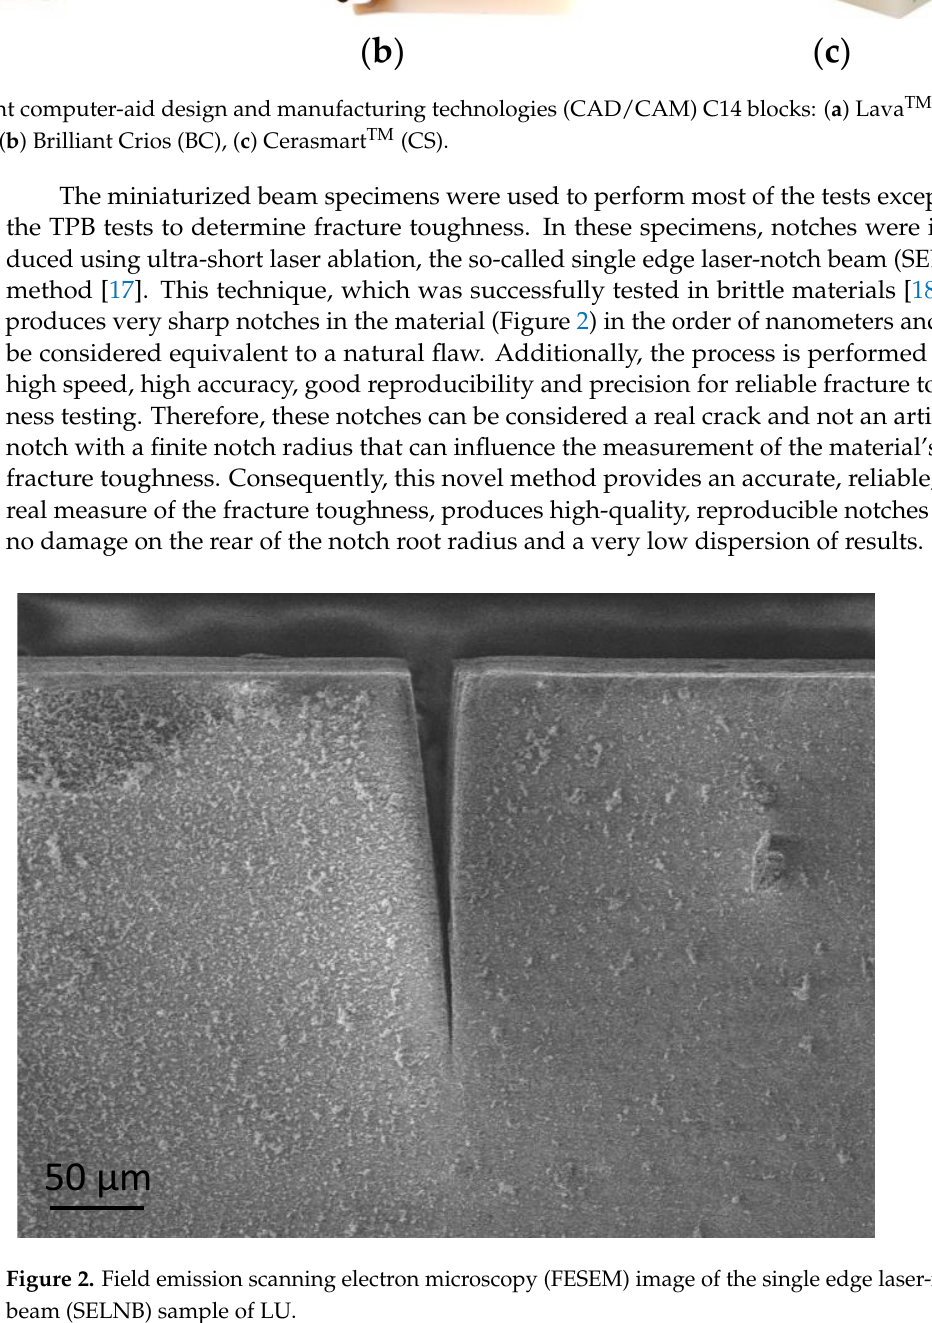
Figure 2. Field emission scanning electron microscopy (FESEM) image of the single edge laser- notch beam (SELNB) sample of LU. 2.2. Ageing Procedure To analyze the influence of the saliva’s direct contact with the tooth, half of the spec- imens were immersed and stored in artificial saliva (AS) at room temperature for 30 days. According to the literature, this time is enough to determine the saliva’s overall influence 50 µm